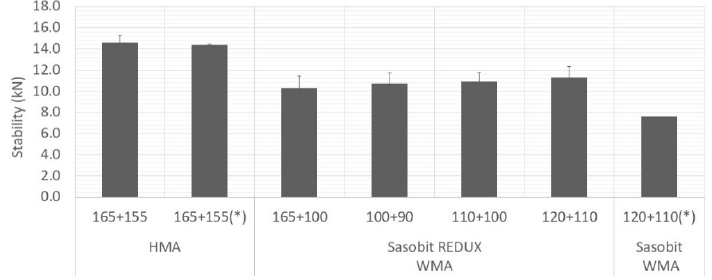
Figure 7. Variation of Marshall stability with mixture and temperature. Materials 2019 , 12 , x FOR PEER REVIEW